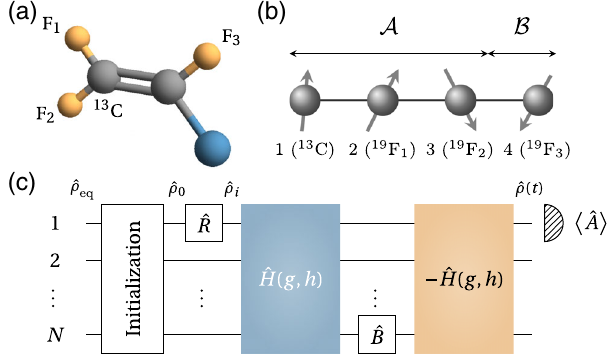
FIG. 1. Illustration of the physical system, the Ising model, and the experimental scheme. (a) The structure of the C 2 F 3 I molecule used for the NMR simulation. (b) The four site Ising spin chain. A and B label two subsystems for the later discussion of the entanglement entropy. (c) Quantum circuit for measuring the OTOC for the general N -site Ising chain when β ¼ 0 (in our case, N ¼ 4 ). Here, ˆ R ¼ 1 , ˆ R